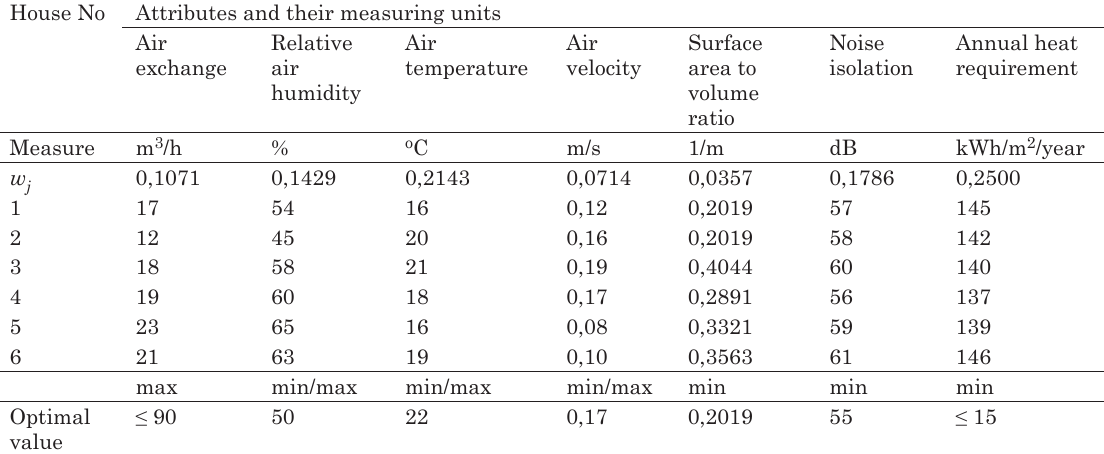
Table 3. Decision-making matrix of the 6 apartments situated in naujoji Vilnia, Vilnius House no attributes and their measuring units